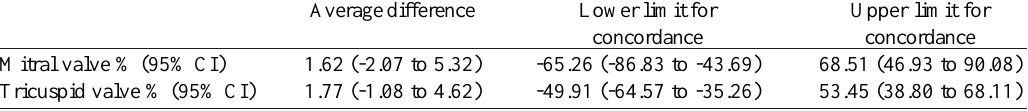
Table 1. Evaluation of the relative agreement between methods for estimating the area of fetal atrioventricular valves by three-dimensional ultrasonography.